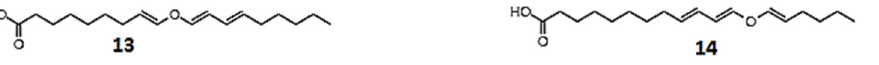
Figure 3. Chemical structures of plant oxylipins, divinyl ether fatty acids: colneleic acid ( 13 ) and etheroleic acid ( 14 ).